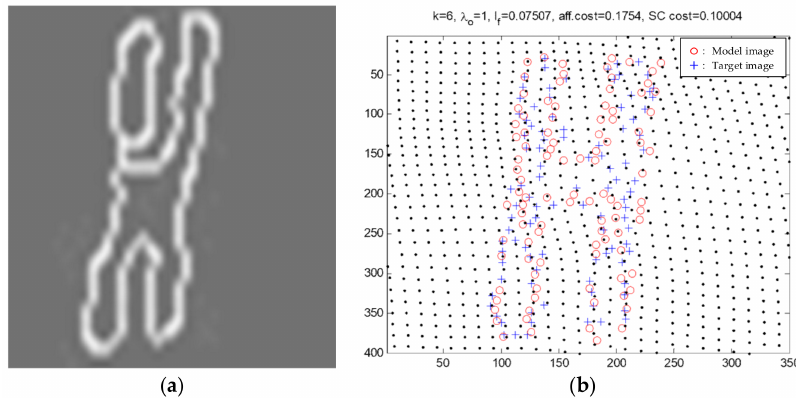
Figure 14. Edge image of a damper in the third dataset by canny algorithm ( a ) and the sixth iteration result by the SC algorithm ( b ).